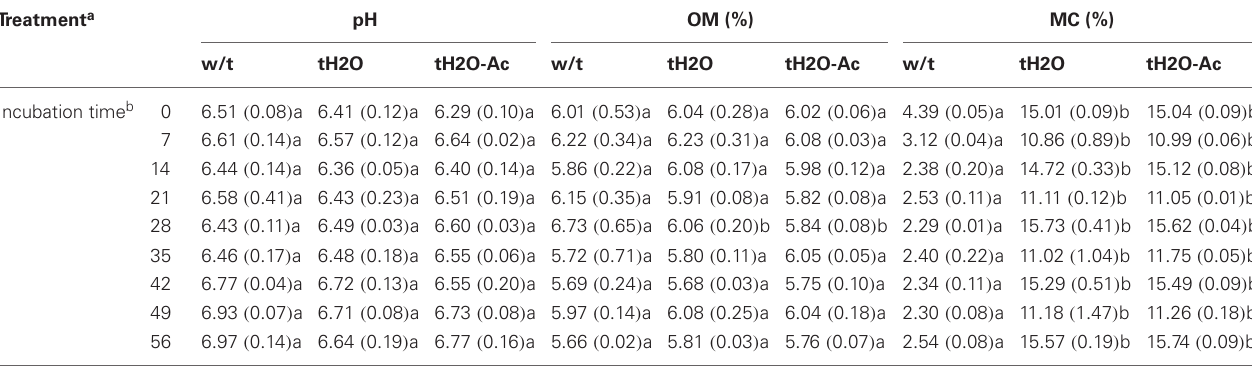
Table 1 | Edaphic factors during microcosms incubation time (mean values; numbers in parenthesis are standard deviation). Treatment